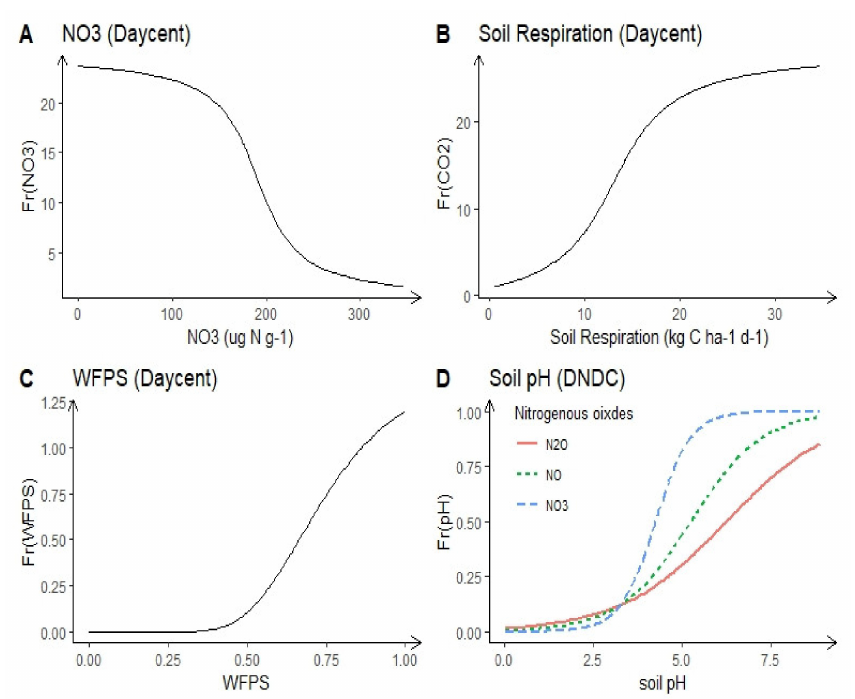
Figure 6. The impact of soil NO 3 − ( A ), soil respiration ( B ), WFPS ( C ), and soil pH ( D ) on the N 2 /N 2 O ratio in DAYCENT and DNDC. The DNDC model shows the impact of soil pH on each nitrogenous oxide ( D